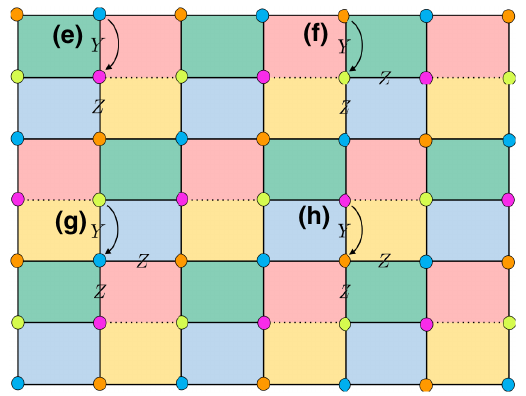
FIG. 21. Labels (e)–(h) denote vertical hoppings i γ L ( e ) γ R ( e ) after a finite-depth GLU transformation in Fig. 19. They match the vertical hoppings in the exact bosonization.